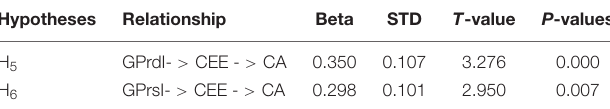
TABLE 5 | Structural model assessment indirect effect (mediation effects).